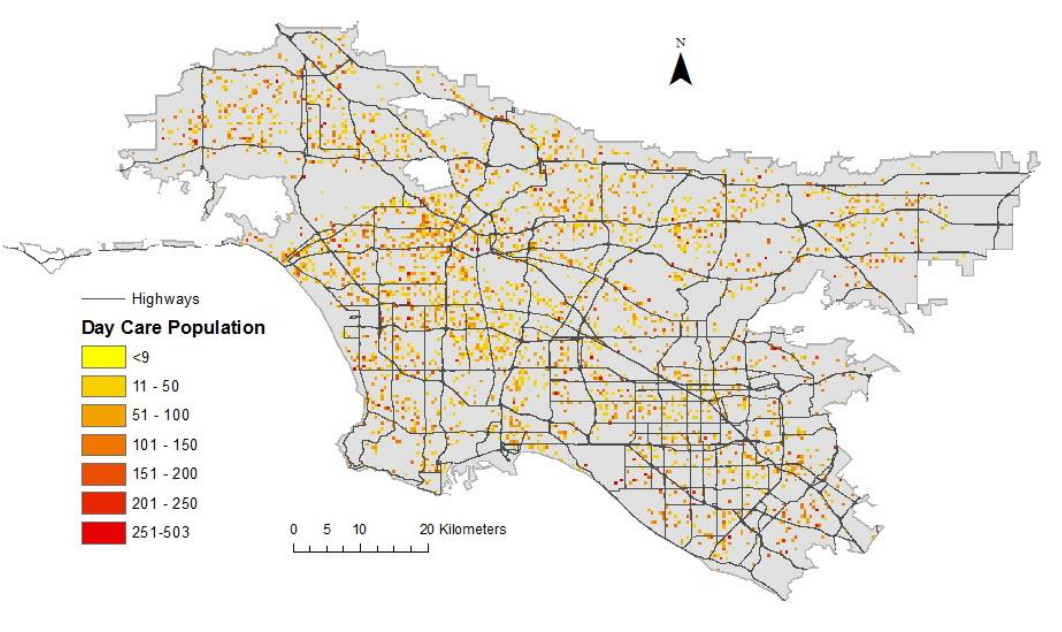
Figure 4. Population distribution of kids in Day Care around highways in the Los Angeles-Long Beach-Anaheim urbanized area in the state of